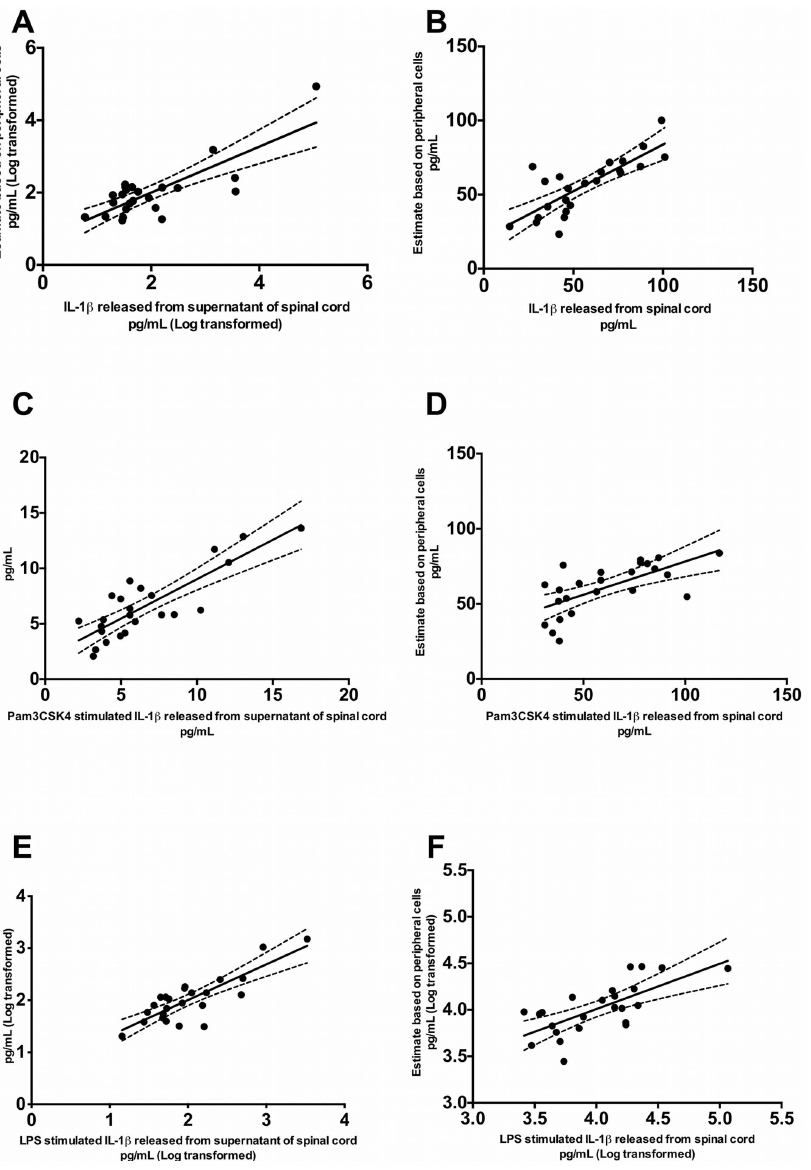
Figure 5. Rat spinal cord (basal, post TLR2 and TLR4 agonist stimulation) was positively correlated with periphery outputs. IL-1 b level released from (A) basal spinal cord supernatant ( P =0.00048, adjusted R-square=0.56) (B) basal spinal cord ( P =0.011, adjusted R-square=0.47) (C) spinal cord supernatant ( P =0.01, adjusted R-square=0.52) (D) spinal cord post Pam3CSK4 ( P =0.04, adjusted R-square=0.29) (TLR2) stimulation at 100 m g/mL (E) spinal cord supernatant ( P =0.02, adjusted R-square=0.48) (F) spinal cord ( P =0.09, adjusted R-square=0.26) post LPS (TLR4) stimulation at 100 m g/mL was found to be significantly correlated with the estimated values predicted from peripheral tissue outputs in rats from Neuronal and subcutaneous. Pearson correlation was used and data shown in panel (A, E and F) have been log transformed and linear regression with 95% confidence interval curves are shown on the graph.